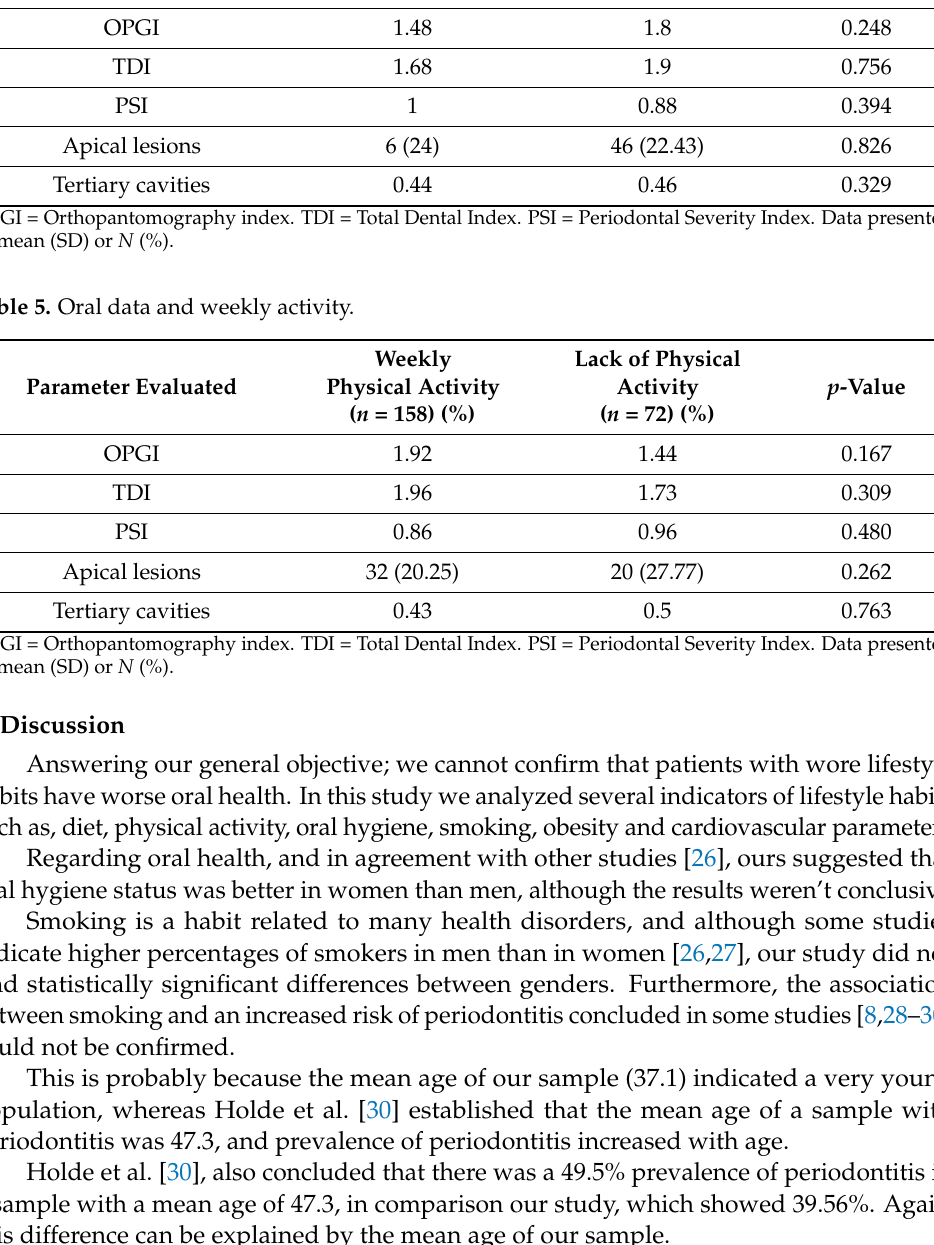
Table 4. Oral data and healthy lifestyle.